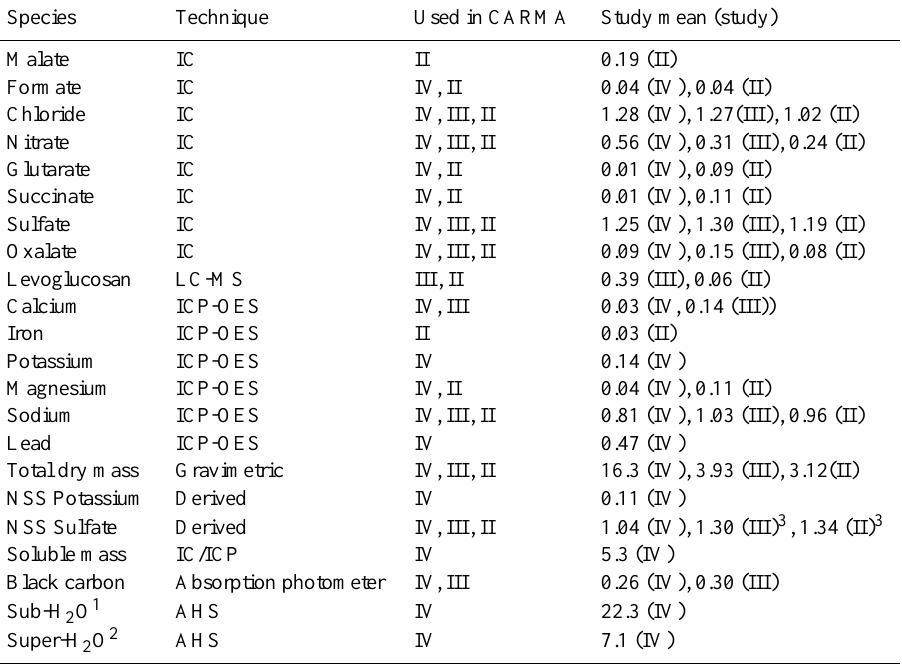
Table 1. Species analyzed from the filter samples obtained in the study and used in at least one of the PMF analyses. Technique acronyms are defined in the text. Mean concentrations found during the study are given (µgm − 3